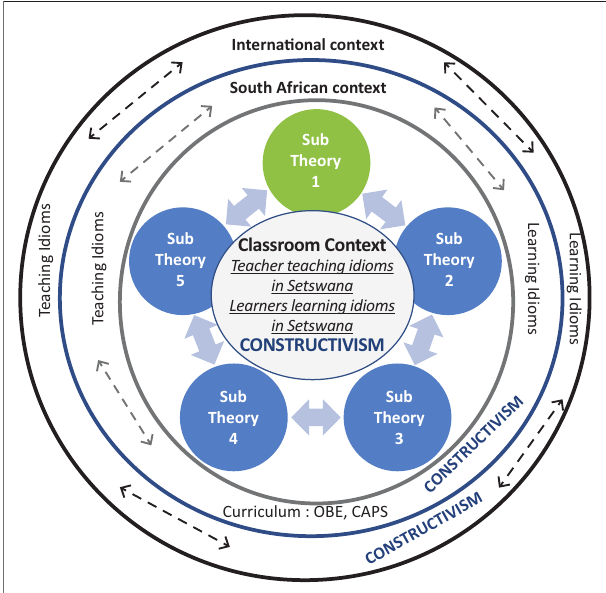
FIGURE 1: Emerging theory of idiom teaching and